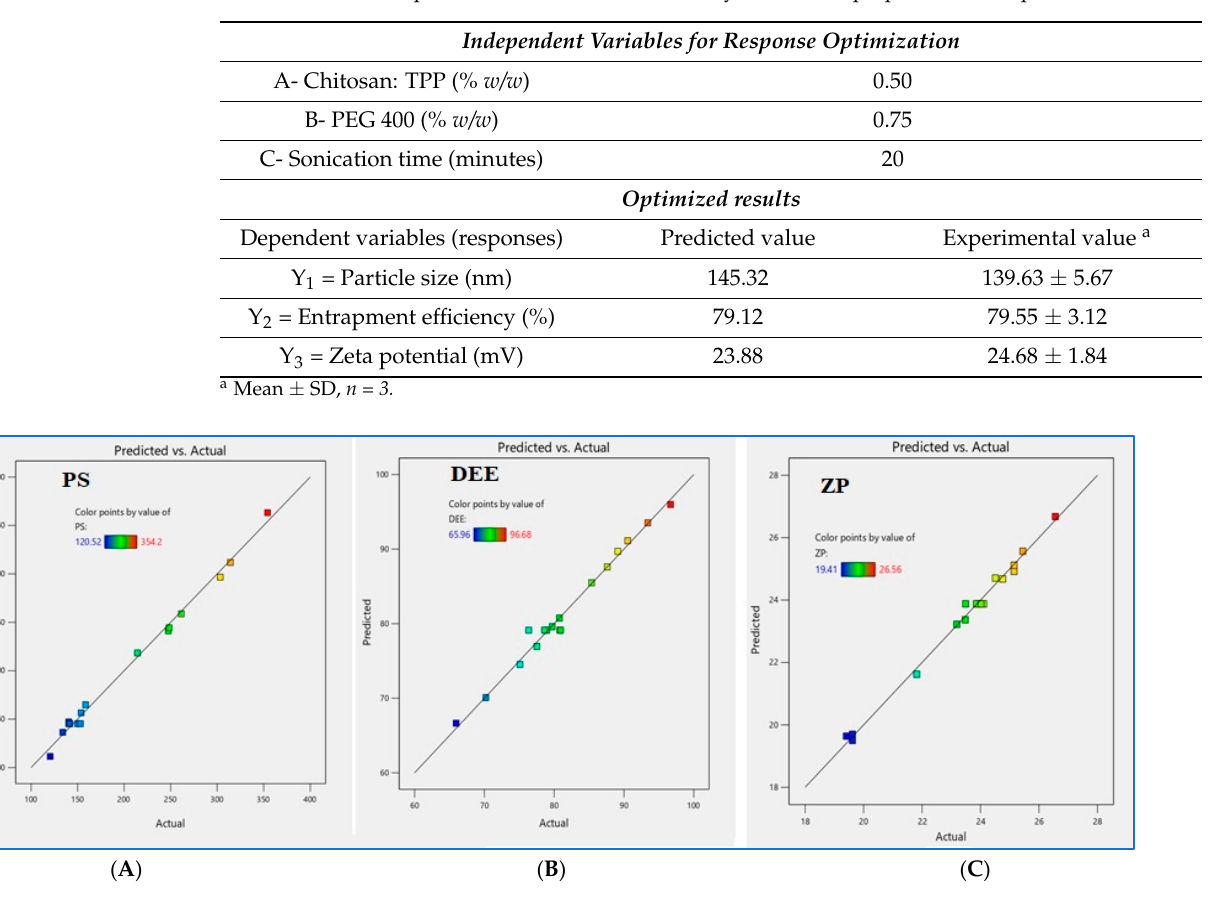
Table 5. Results of optimization of APG-loaded PEGylated-CNPs prepared under optimum condition.